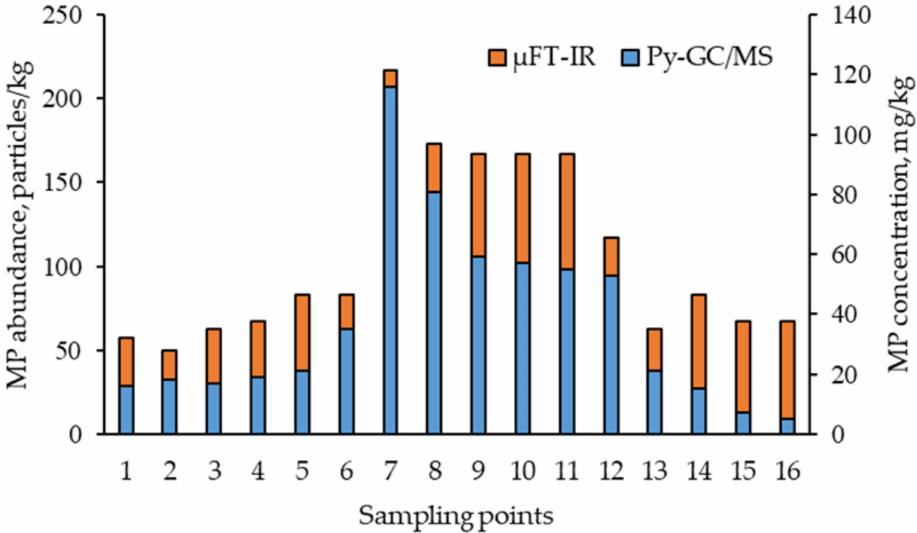
Figure 2. The total content of microplastics in the sampling